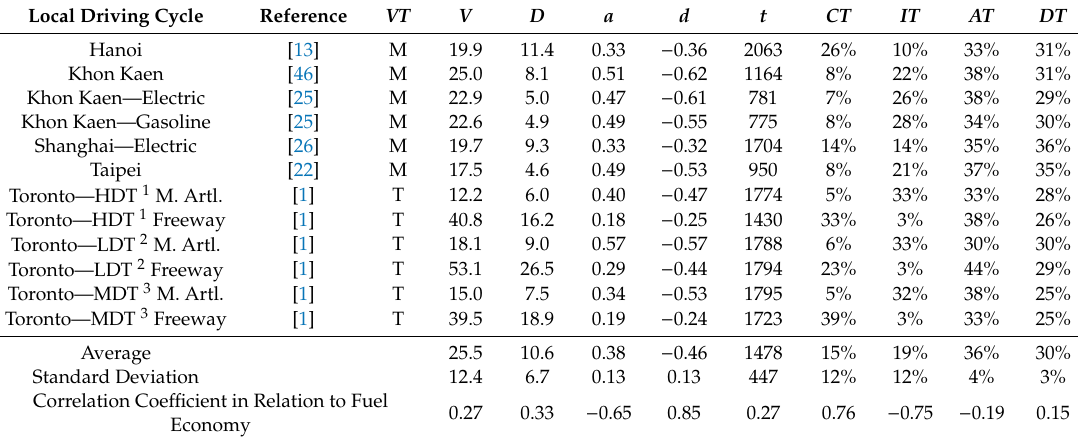
Table 8. CP ENV of LDCs for trucks (T) and motorcycles (M).